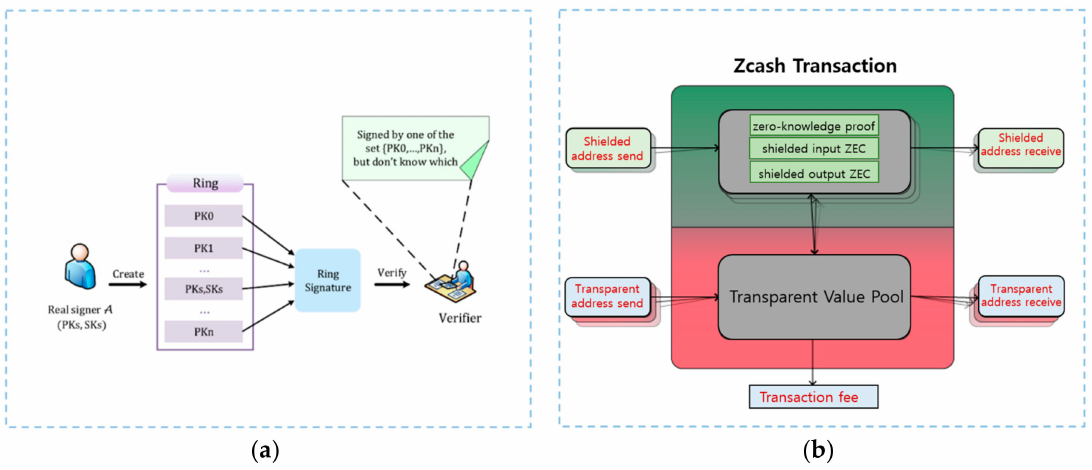
Figure 8. ( a ) Ring signature anonymity; ( b ) high-level view of a ZCash (ZEC) transaction.